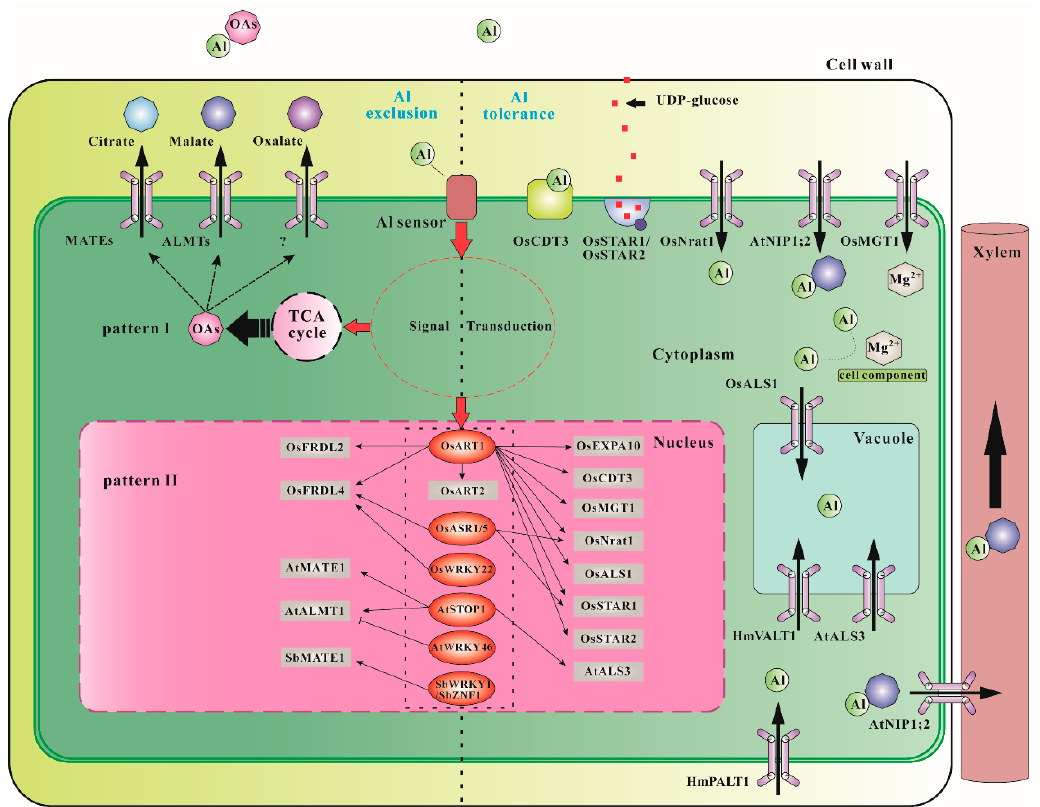
Figure 1. Mechanisms of Al tolerance in plants. MATEs, multidrug and toxic compound extrusion for citrate transport; ALMTs, aluminum-activated malate transporters; OsCDT3, a small peptide with rich cysteine; OsSTAR1/OsSTAR2, UDP-glucose transporter; OsEXPA10, an expansin gene; OsNrat1, plasma membrane-localized Al transporter; AtNIP1;2, plasma membrane-localized Al-malate transporter; AtALS3, plasma membrane-localized Al transporter; HmPALT1, plasma membrane-localized Al transporter; OsMGT1, magnesium transporter; OsALS1, tonoplast-localized Al transporter; HmVALT1, tonoplast-localized Al transporter; OsFRDL2/4, citrate transporter; AtMATE1, citrate transporter; AtALMT1, malate transporter; OsASR1/5, ABA-stress and ripening 1/5; OsART1/2, C 2 H 2 -type zinc finger transcription factor; AtSTOP1, C2H2-type zinc finger transcription factor; OsWRKY22, WRKY transcription factor; AtWRKY46, WRKY transcription factor; SbWRKY1, WRKY transcription factor; SbZNF1, DHHC-type zinc finger transcription factor; SbMATE1, citrate transporter.